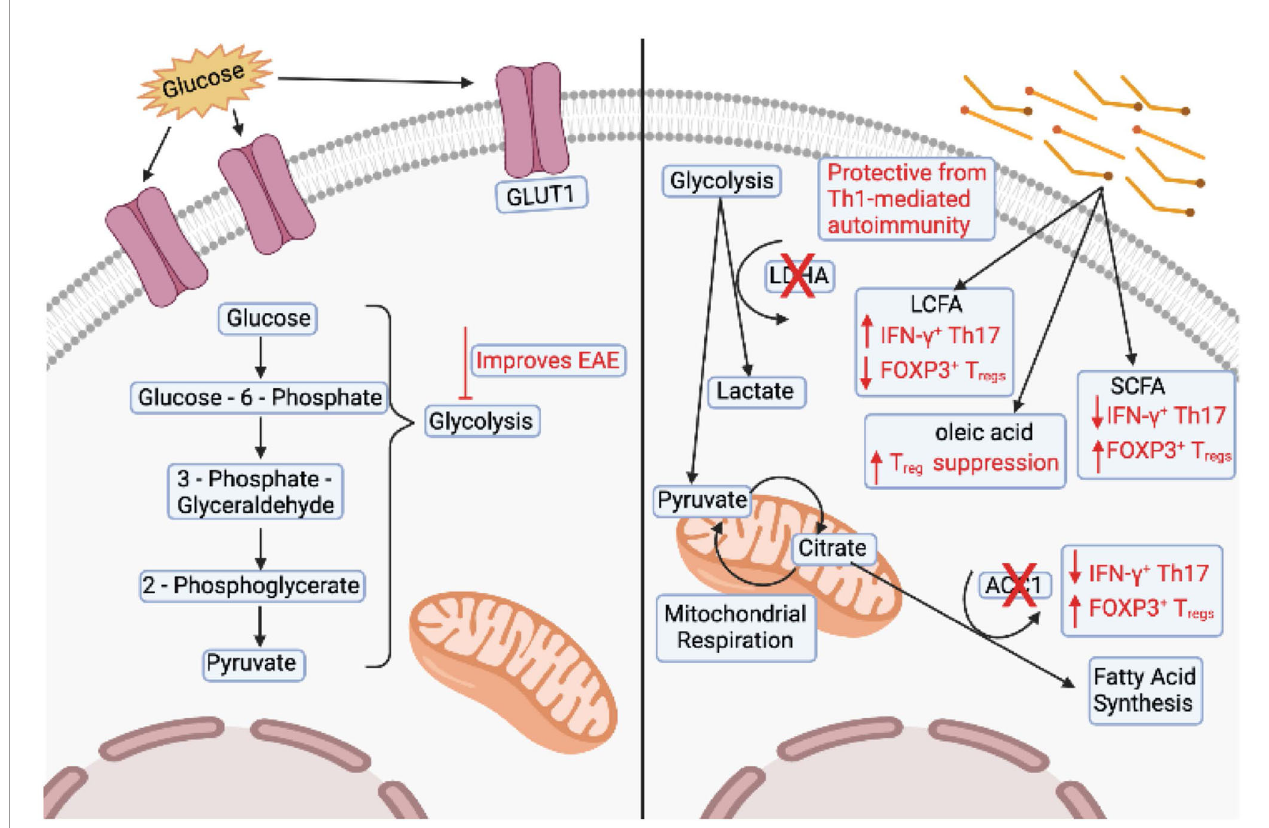
FIGURE 3 | Changes in T cells associated with multiple sclerosis. The left panel shows overexpression of GLUT1 and dysregulation of glycolysis associated with T cells in experimental autoimmune encephalomyelitis (EAE) models. Inhibition of glycolysis also improves clinical outcomes of EAE. The right panel shows that deletion of lactate dehydrogenase (LDHA) is protective in Th1-mediated autoimmunity. Deletion of acetyl-CoA carboxylase 1 (ACC1) in T cells decreases the number of interferon (IFN)- g + Th17 cells and increases the number of FOXP3+ Treg cells. Mice fed long chain fatty acids (LCFAs) have an increased number of IFN- g + and IL-17+ T cells and a decreased number of FOXP3+ cells. Conversely, mice fed short chain fatty acids (SCFAs) have an decreased number of IFN- g + and IL-17+ T cells and an increased number of FOXP3+ cells. Finally, T cells cultured in the presence of LCFA, oleic acid, can partially restore Treg suppression. Image created with